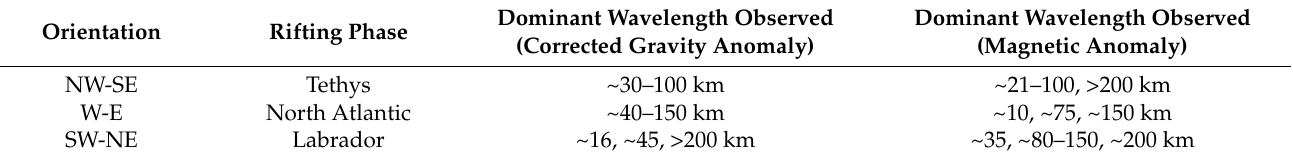
Table 2. Dominant Boudinage Wavelengths Observed in Potential Field Data Corresponding to Each Rift Phase.